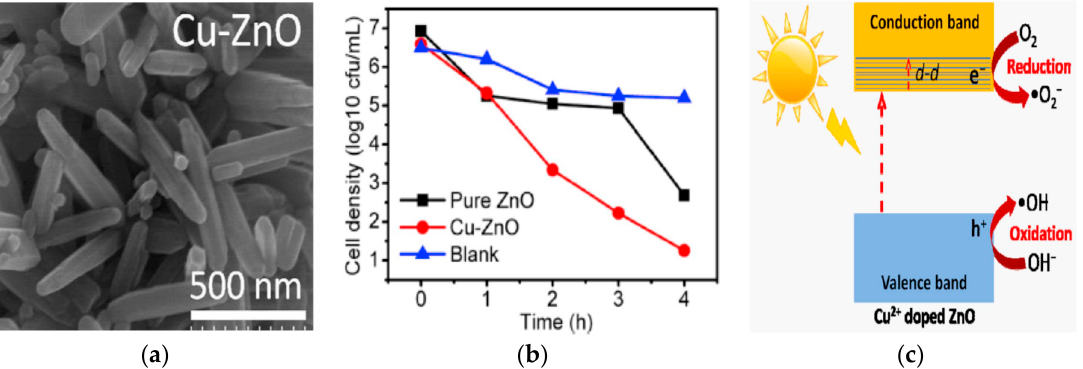
Figure 34. ( a ) SEM image showing morphology of Cu-doped ZnO nanorods; ( b ) Photocatalytic e ffi ciency of ZnO NPs and Cu / ZnO nanorods against E. coli under simulated solar light irradiation; ( c ) Photocatalytic mechanism of Cu / ZnO nanorods under solar light. Reproduced from [298] with permission from